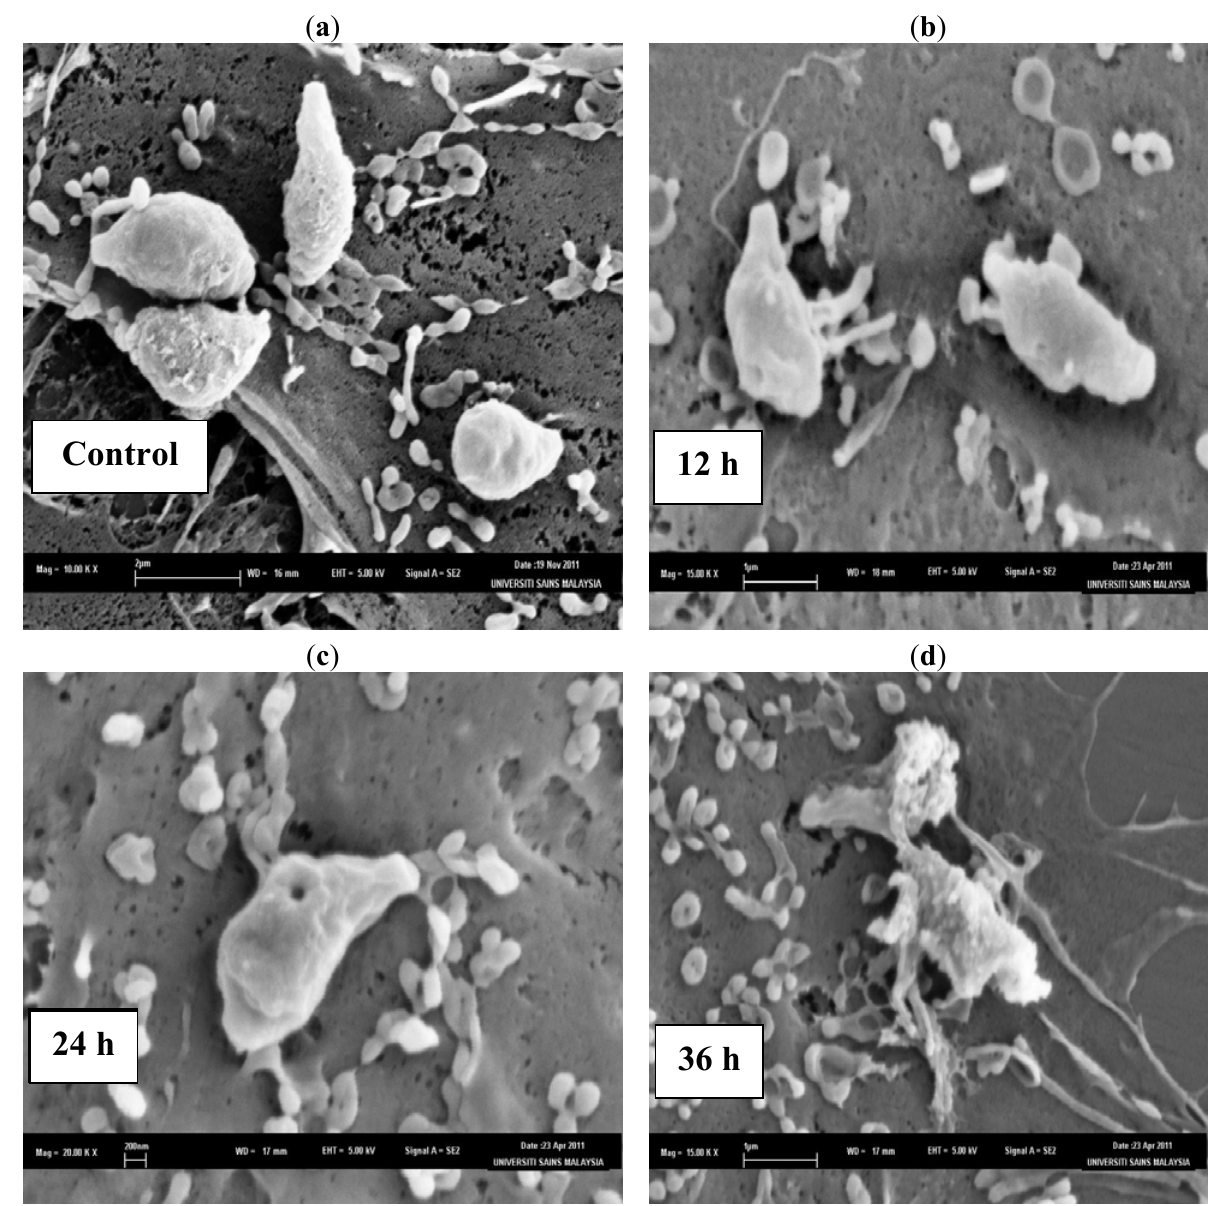
Figure 3. SEM micrograph of the untreated and TAF401 treated cells of T. gondii for different time interval. ( a ) Untreated cells, ( b ) 12 h of exposure, ( c ) 24 h treated cells, ( d ) 36 h of